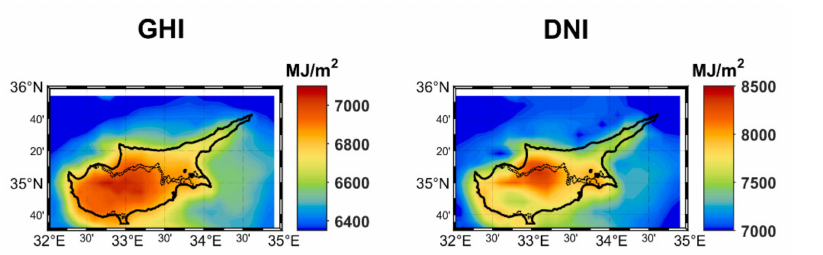
Figure 9. Total annual all-sky GHI and DNI. Although detailed comparison between SSR simulated using MODIS aerosols and SSR from CMSAF was out of the scope of the present study, the GHI and DNI from the two climatologies were compared for the five locations shown in Figure 2 in order to provide an estimate of the magnitude of the differences between the two datasets. Comparison between the two datasets revealed a relatively good agreement at lower altitude areas and larger differences at higher altitudes. Examples of the differences for five locations are shown in Table